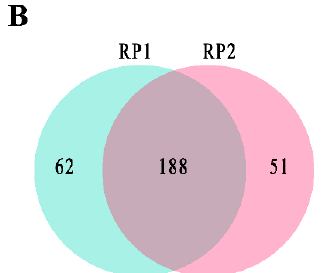
Figure 1. Global identification of lysine acetylation in two virulent strains T. gondii RH strain and PYS strain. Venn diagrams show the number of unique and common acetylated proteins in RP1 and RP2 of ( A ) RH strain, ( B ) PYS strain.